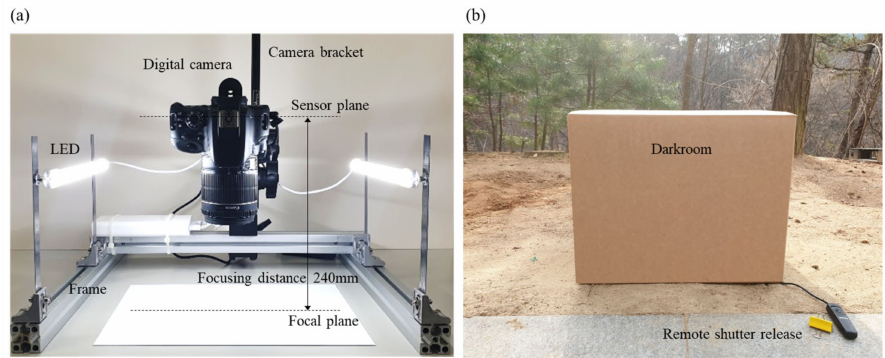
Figure 1. Camera setting for in situ image acquisition: ( a ) camera and lighting setting; ( b ) darkroom and remote shutter